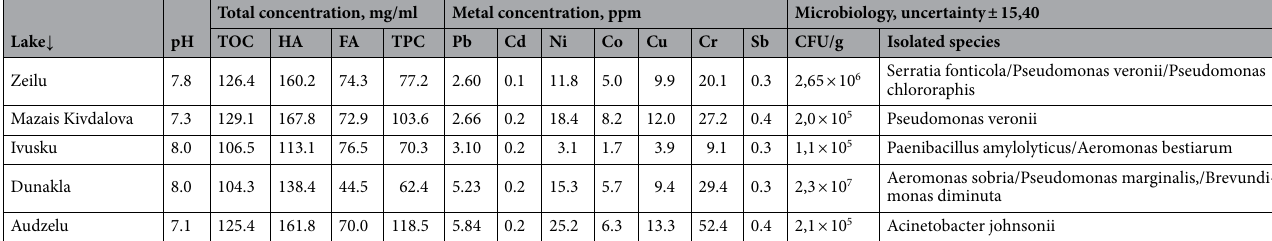
Table 3. Concentration of metals, humic and fulvic acids, total organic carbon and